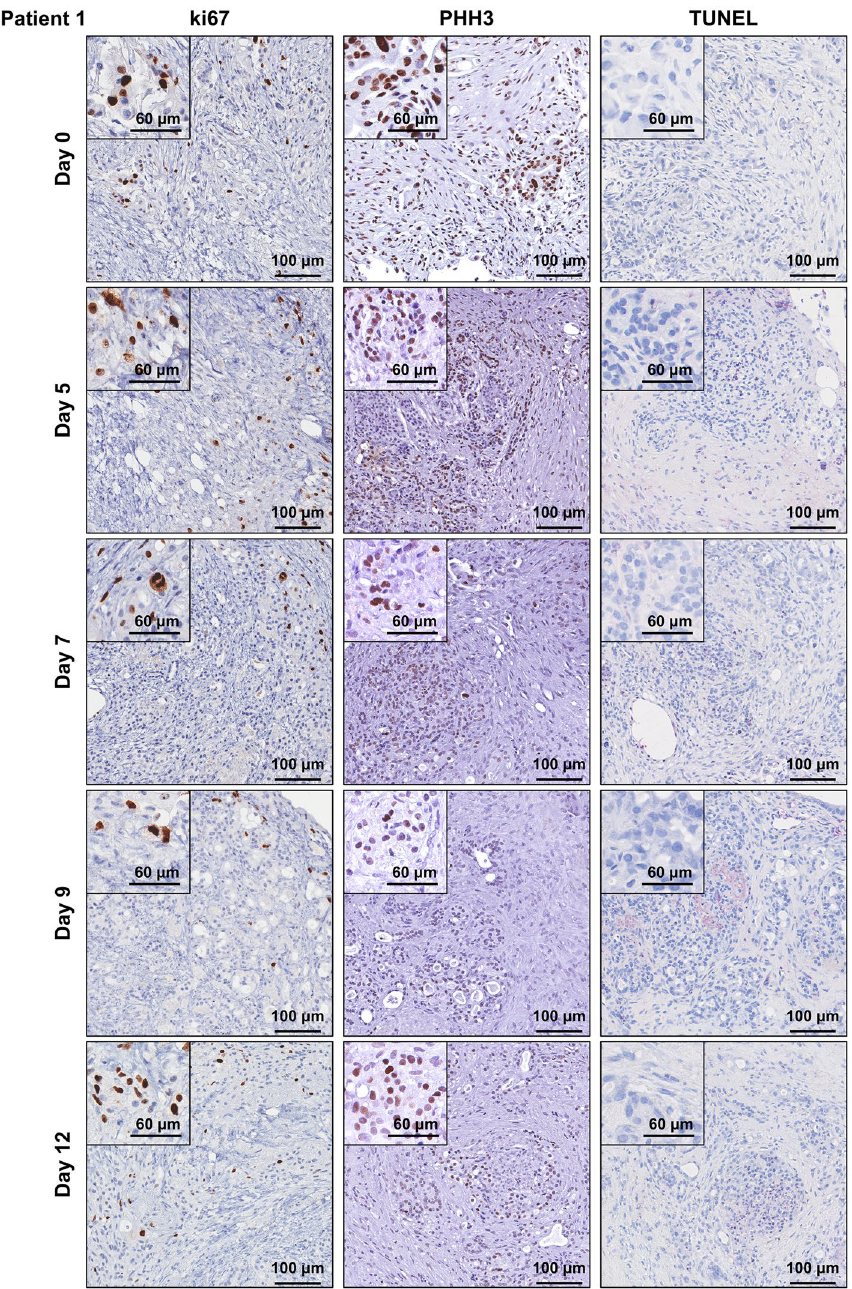
Figure 3. Human patient derived pancreatic ductal adenocarcinoma tumour explants remain viable for 12 days of culture. Immunohistochemistry was performed for ki67, phospho-histone H3 (PHH3) and TUNEL on patient 1 explants from days 0–12. Insets show representative higher magnification